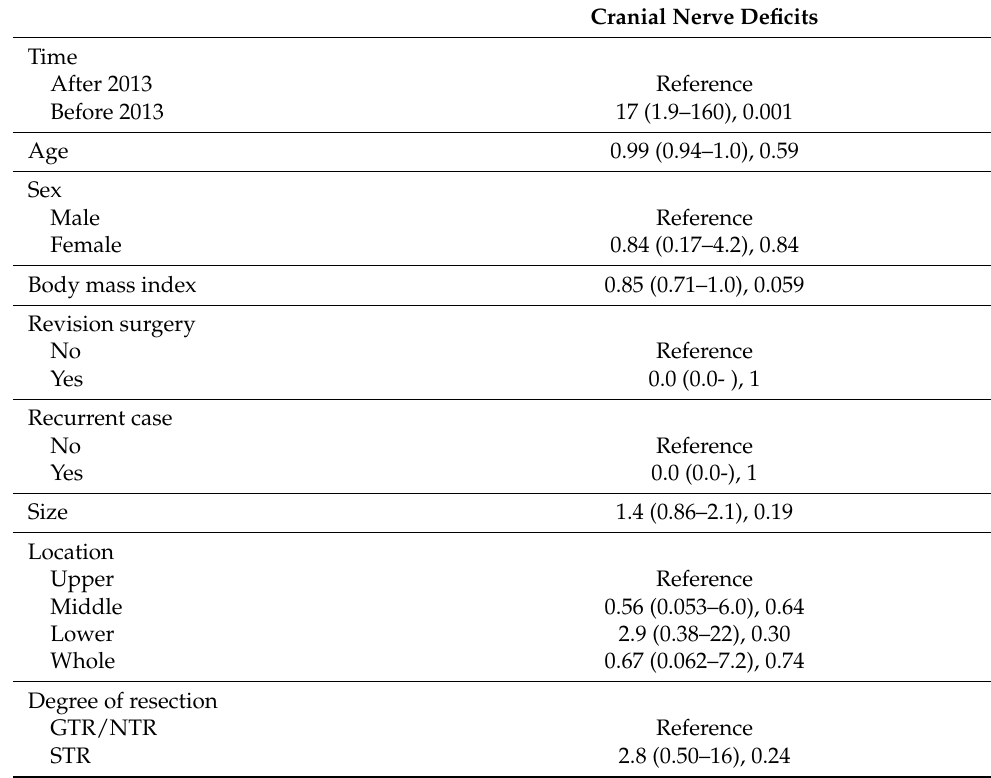
Table 3. The result of binary logistic regression analysis on postoperative new cranial nerve